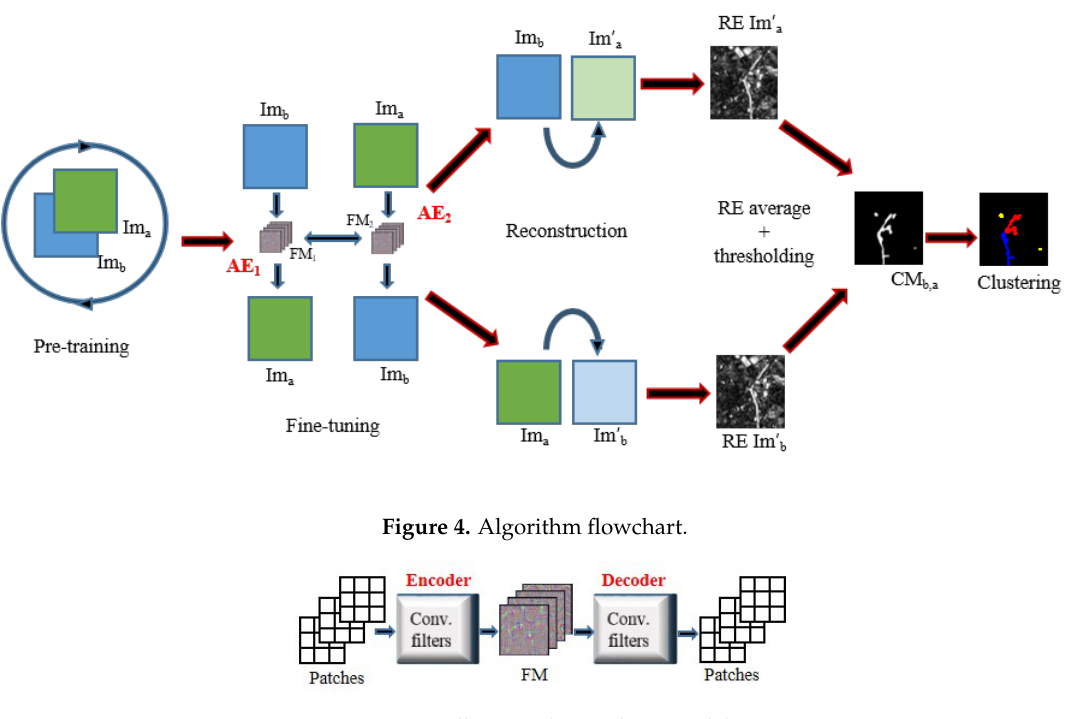
Figure 5. Fully convolutional AE